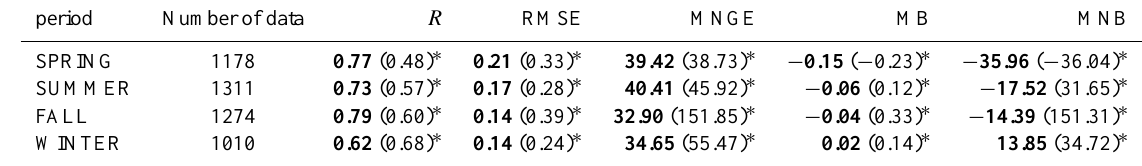
Table 7. Statistical values between the CMAQ-simulated and MODIS-retrieved AODs for all four seasons, 2006, over East Asia. period Number of data R RMSE MNGE MB MNB SPRING SUMMER